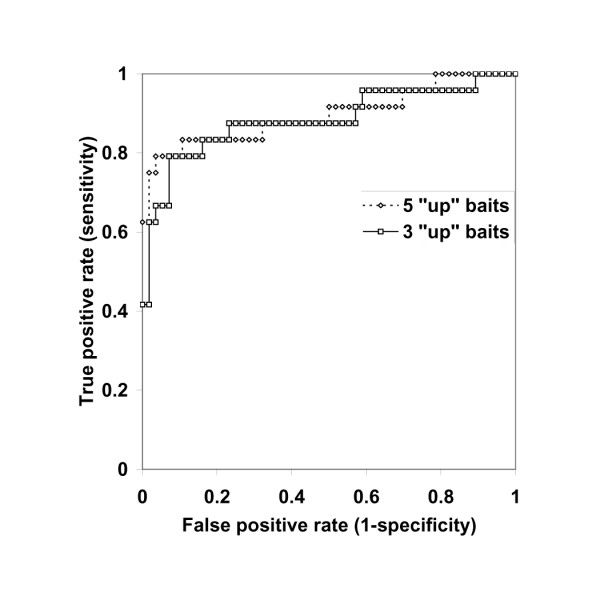
Receiver Operating Characteristic (ROC) curves from leave-one-out validation of a Diagonal Linear Discriminant Analysis classifier using the best 3 (or 5) antibodies. Both the antibodies selected and the discriminant function were based solely on the remaining 79 samples.